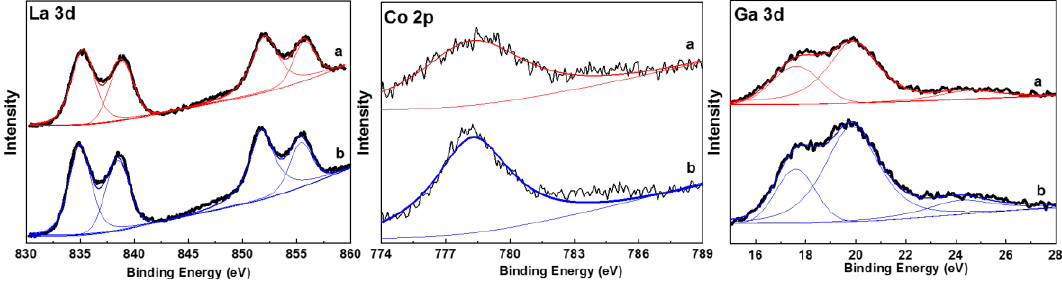
Figure 4. X-ray photoelectron spectroscopy (XPS) profiles of La 3d, Co 2p and Ga 3d of the reduced ( a ) LCG and ( b ) LKCG-0.1. Table 3. The binding energies of the reduced LCG and LKCG-0.1 catalysts.